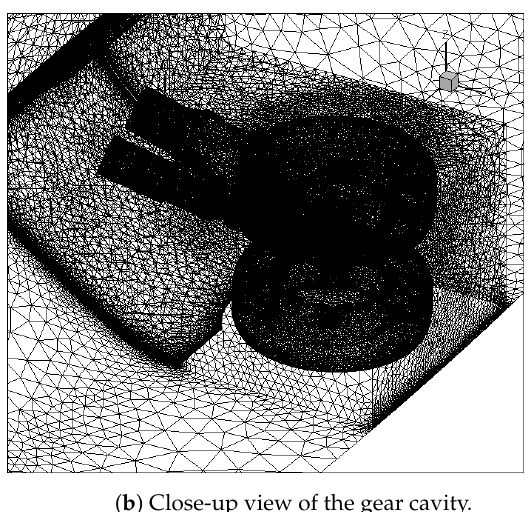
Figure 7. MLG: initial computational